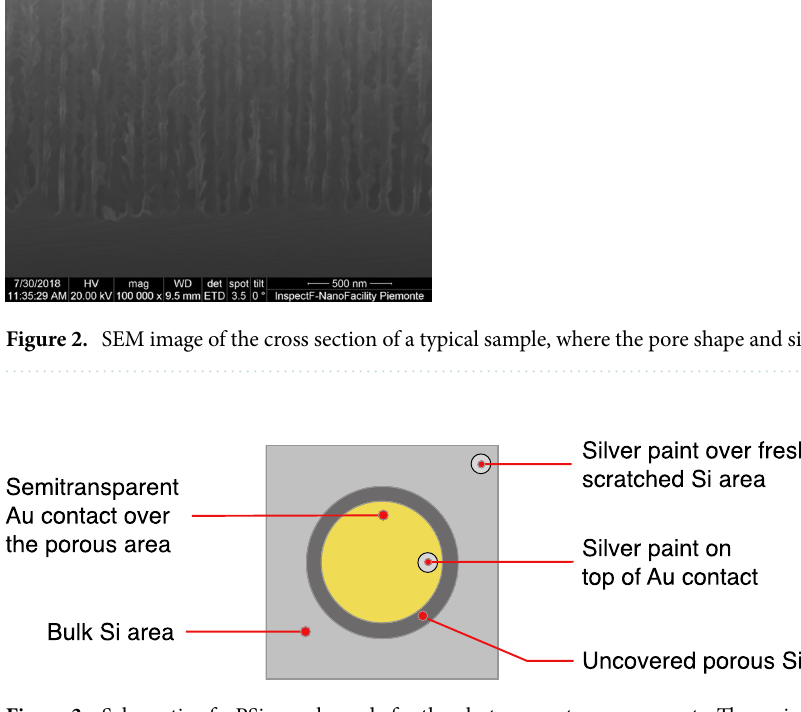
Fig. 3. The samples photoconductivity was tested in a PM8 Analytical probe using a tungsten halogen lamp and a Keithley 2640 multimeter. No external voltage was applied during the photocurrent measurements. The current values were recorded after stabilization of the photocurrent values (two minutes).